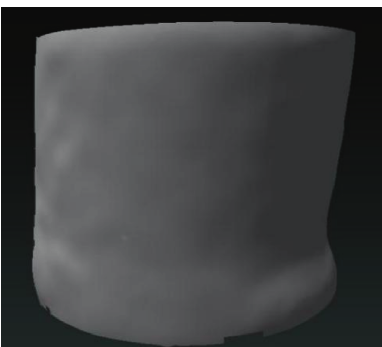
Figure 18: Reconstructed